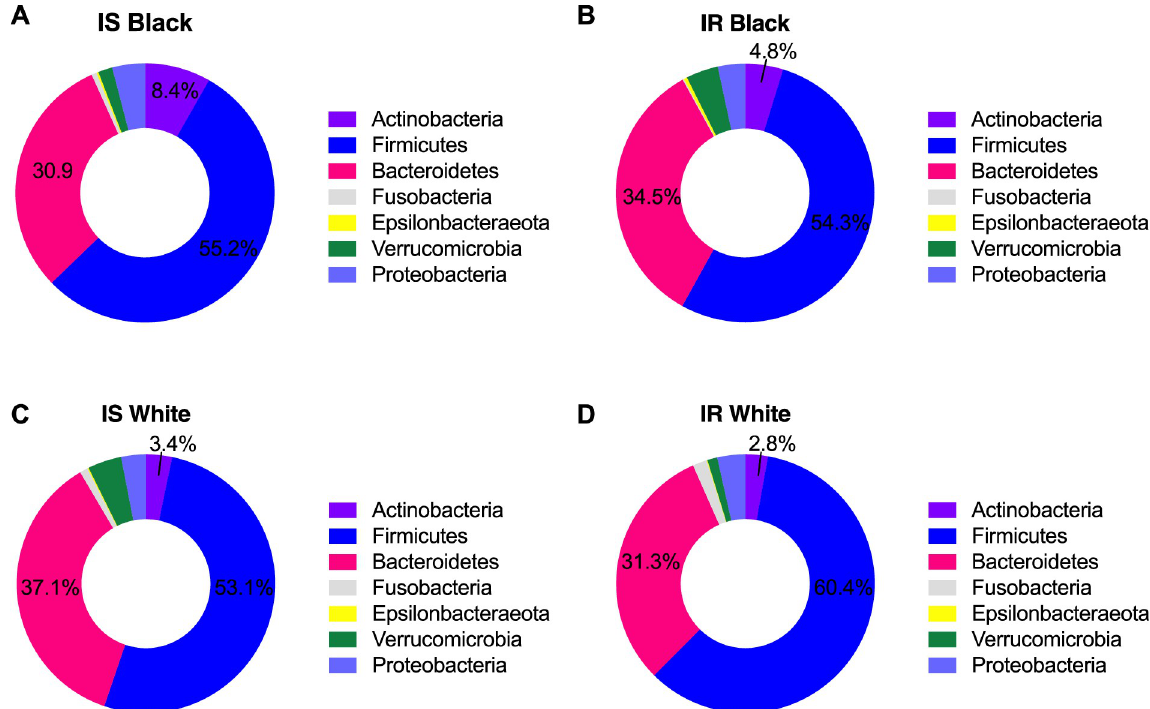
Fig 2. Relative abundance of bacterial phylum in fecal samples by race and insulin sensitivity status. Relative abundance was measured by 16S rRNA gene PCR and sequencing.